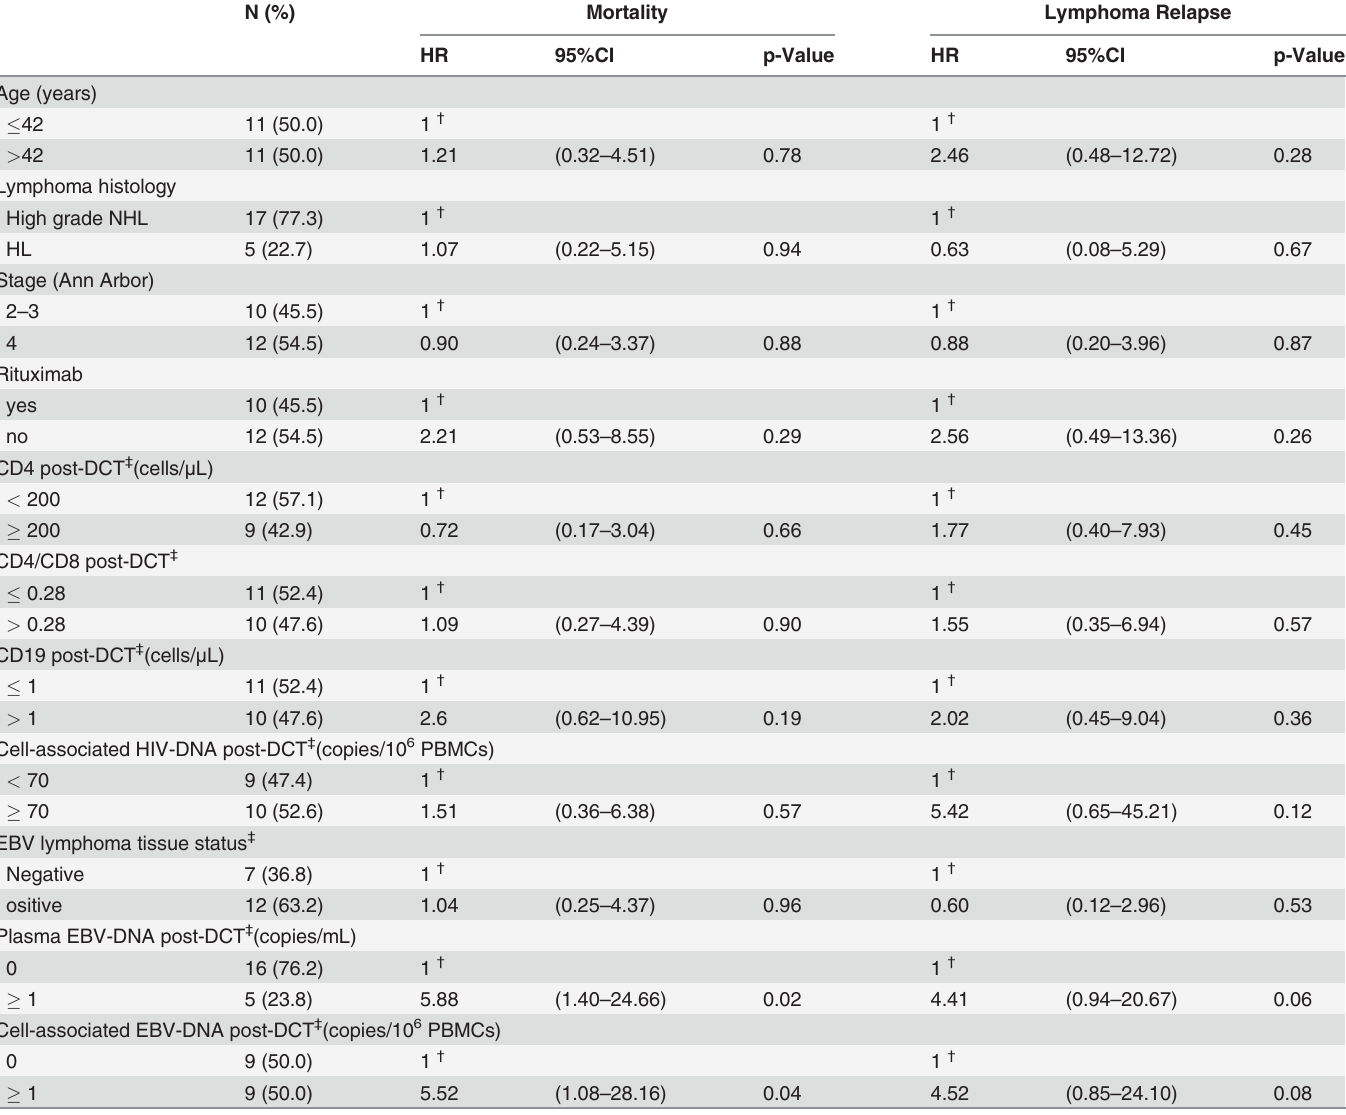
Table 3. Hazard ratio (HR) and corresponding 95% con fi dence interval (CI) for mortality and lymphoma relapse evaluated by demographic, clinical, histological, virological and immunological